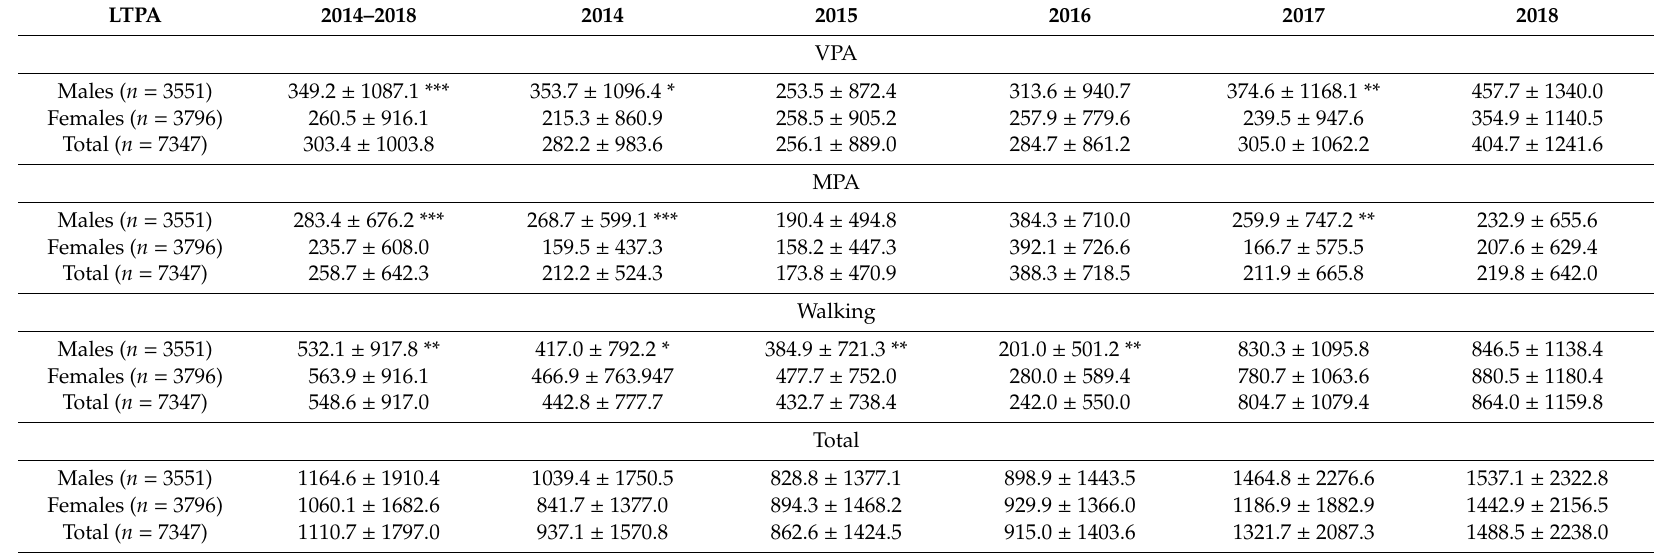
Table 2. LTPA (VPA, MPA, Walking) in MET-min / week declared by males and females in 2014–2018 ( x and ± SD).